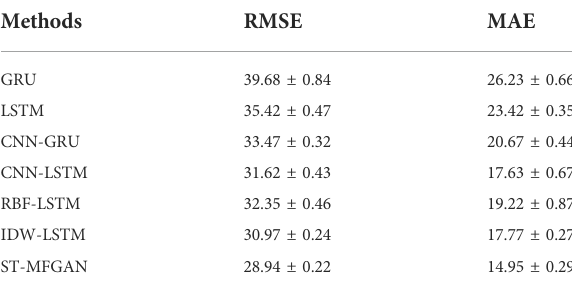
TABLE 1 The RMSE and MAE of the fi ve methods in the test set. Methods